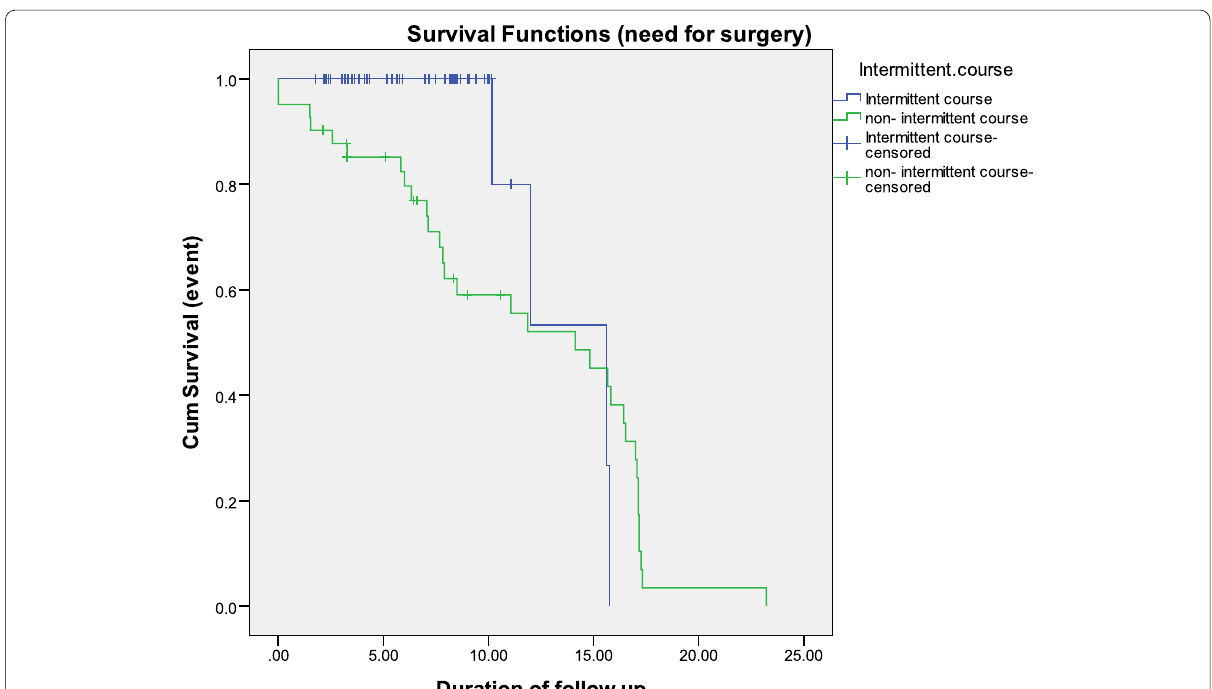
Fig. 3 Log rank analysis between cases with and without intermittent course regarding time to surgery showed a statistically significant difference ( p =